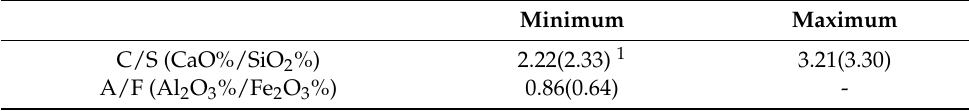
Table 13. Applicable range of the proposed